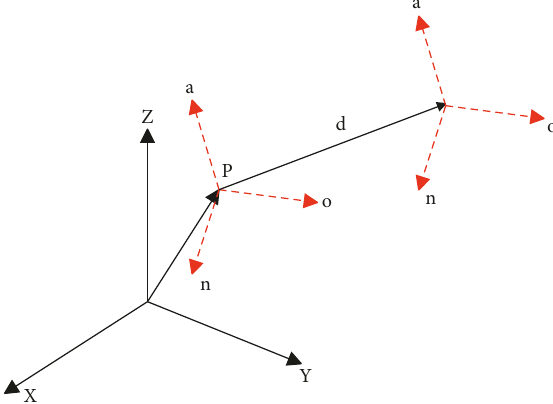
Figure 7: Space vector.